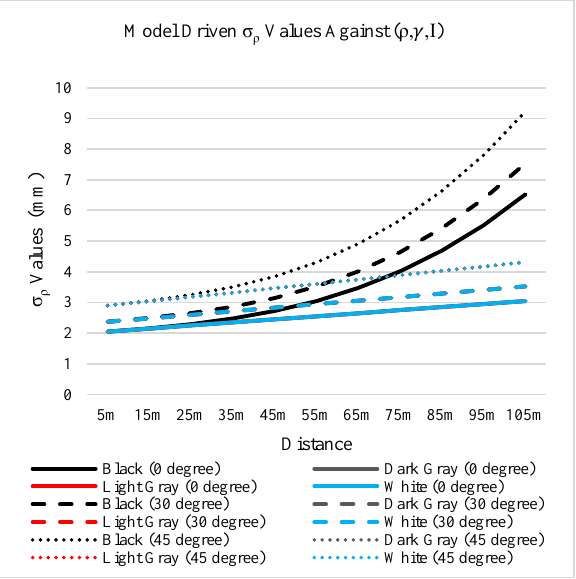
Figure 8. Model driven σ ρ values